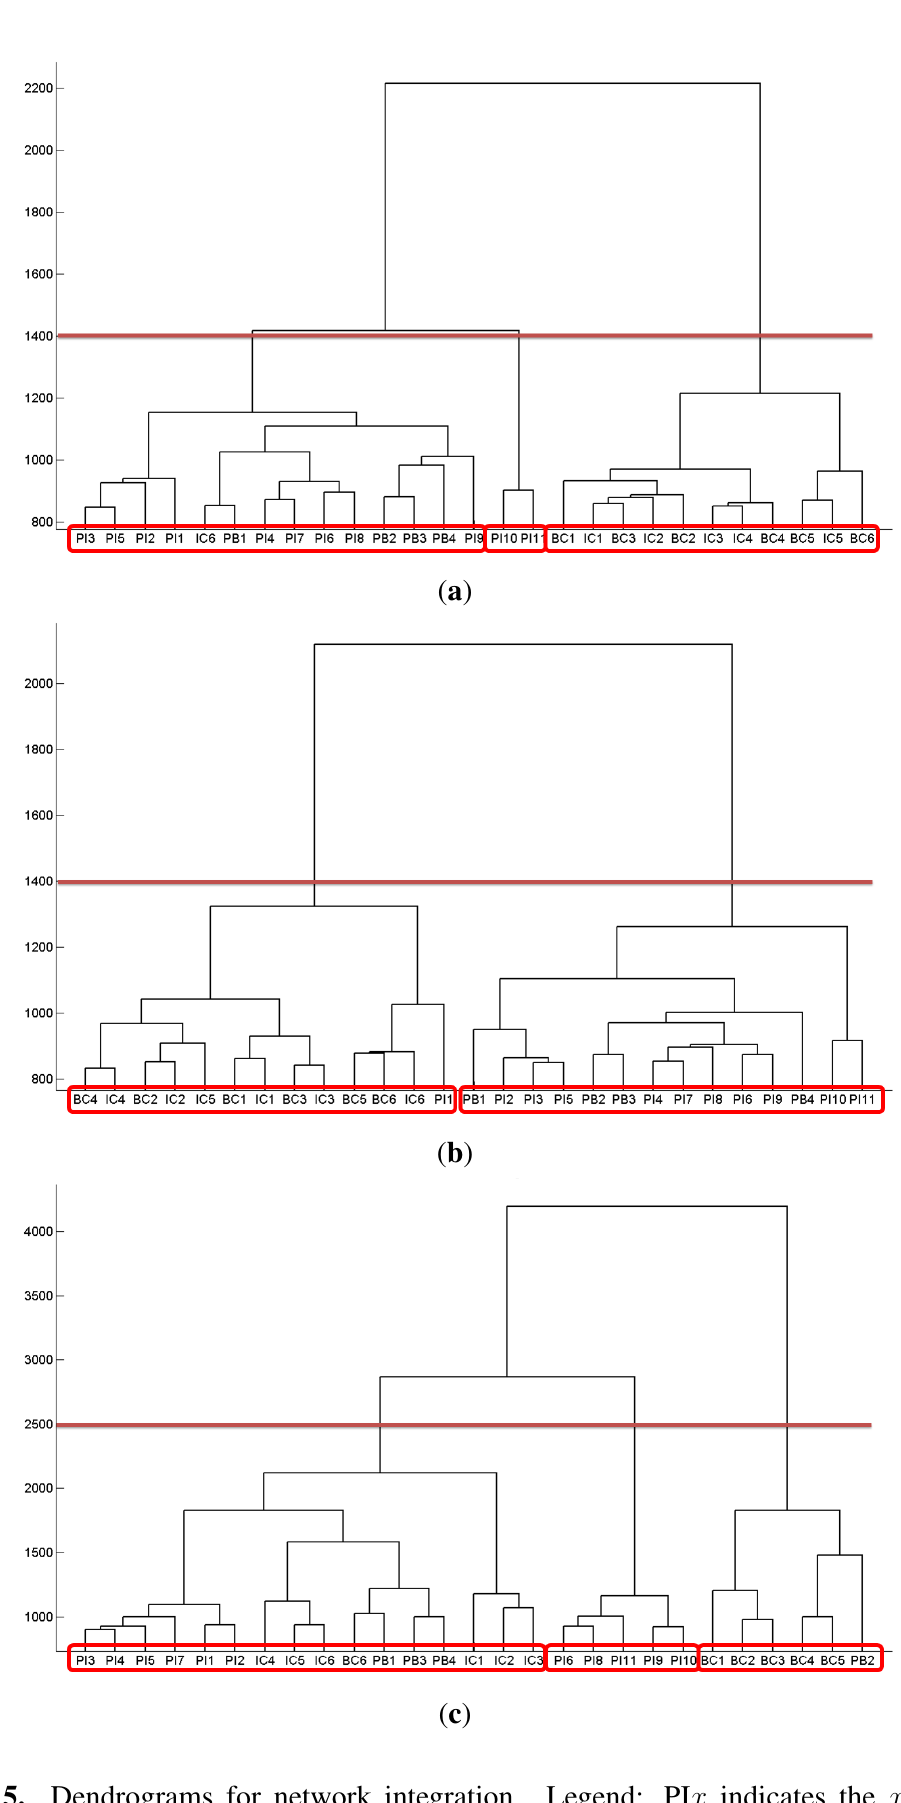
Figure 5. Dendrograms for network integration. Legend: PI x indicates the x -th pure insurer; PB y indicates the y -th pure bank; IC z the insurance component of the z -th financial conglomerate; and BC z the banking component of the z -th financial conglomerate. Source: ACPR data, authors’ calculation. ( a ) Volume (exposures in e ); ( b ) credit risk (exposures in % of owner’s equity); ( c ) funding risk (exposures in % of issuer’s